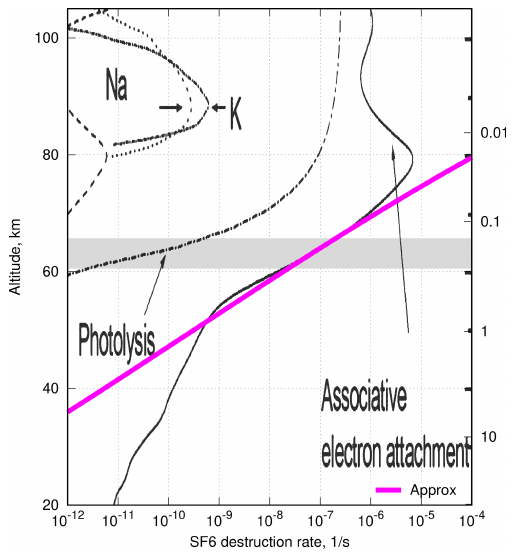
Figure 2. The vertical profiles of SF 6 destruction rate (after Totter- dill et al., 2015) and its approximation in the range of 55–75km, given by Eq.